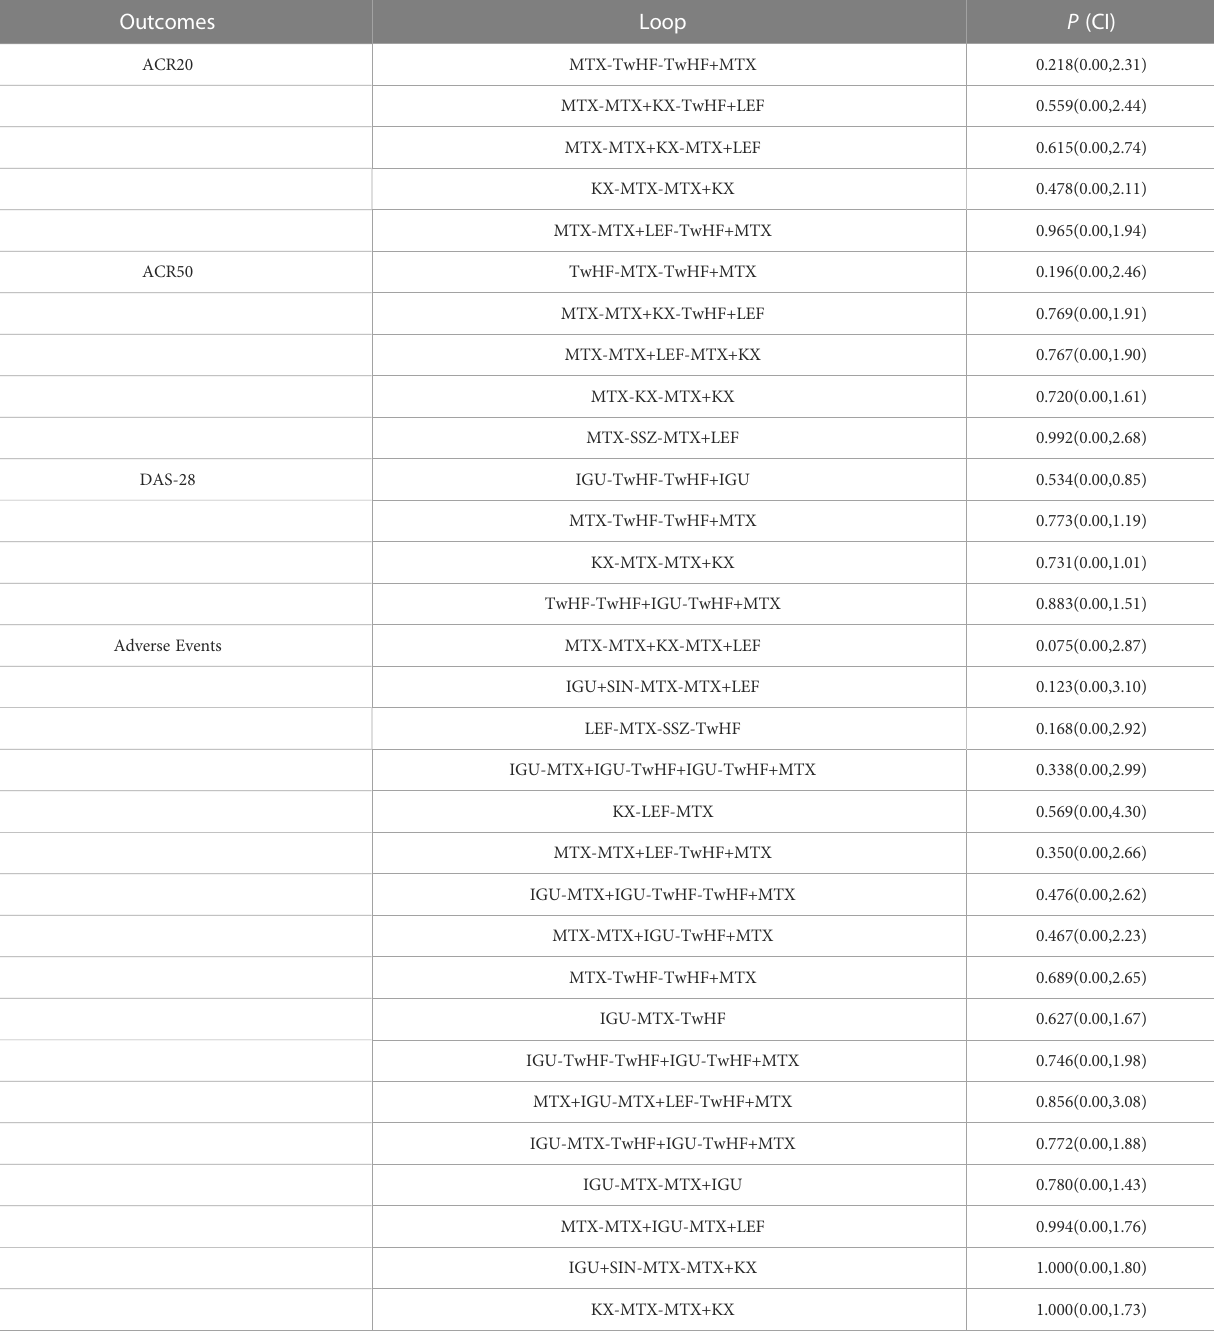
TABLE 2 the closed loop with all outcomes.